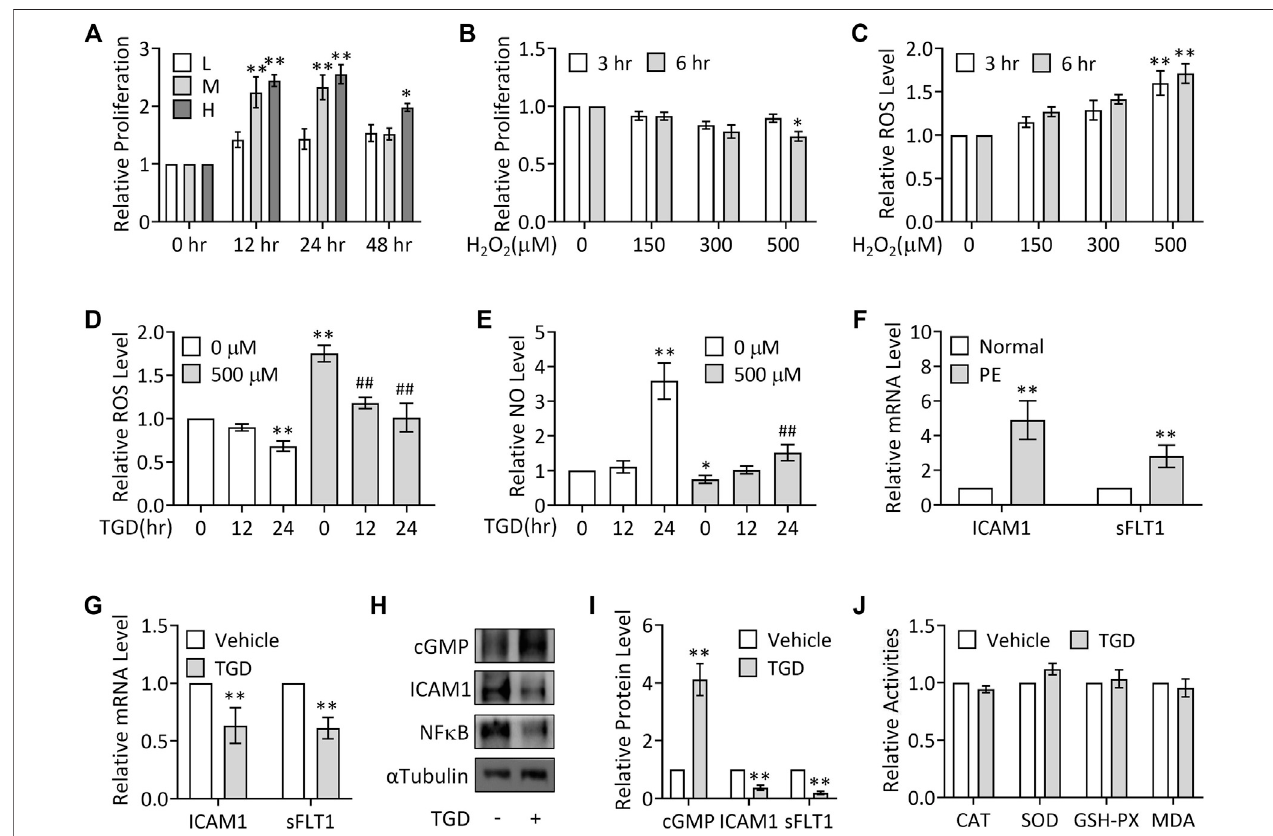
FIGURE2| TGDinhibitsROSgenerationandelevatesNOproduction. (A) CCK-8assaysinTEV-1cellstreatedwithTGDat25 mg/ml(L),50 mg/ml(M)or100 mg/ ml(H)for12,24or48 h (B) CCK-8assaysinTEV-1cellstreatedwithH 2 O 2 at150 μ M,300 μ Mor500 μ Mfor3 hor6 h (C) RelativeROSlevelsinTEV-1cellstreatedwith H 2 O 2 at150 μ M,300 μ Mor500 μ Mfor3 hor6 h (D) RelativeROSlevelsinTEV-1cellsinthepresenceorabsenceof500 μ MH 2 O 2 for3 handthentreatedwithTGDat 25 mg/mlfor12 hor24 h (E) RelativeNOlevelsinTEV-1cellsinthepresenceorabsenceof500 μ MH 2 O 2 for3 handthentreatedwithTGDat25 mg/mlfor12